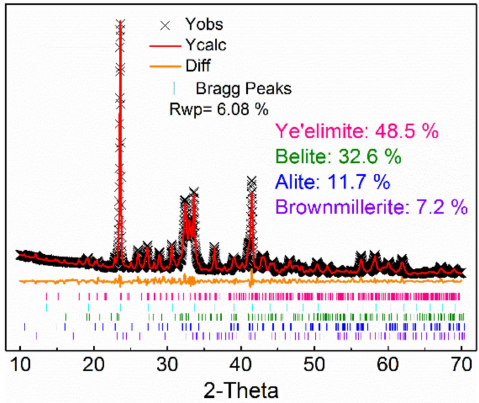
Figure 2. Quantitative analysis fitting of AMCSA clinker minerals.